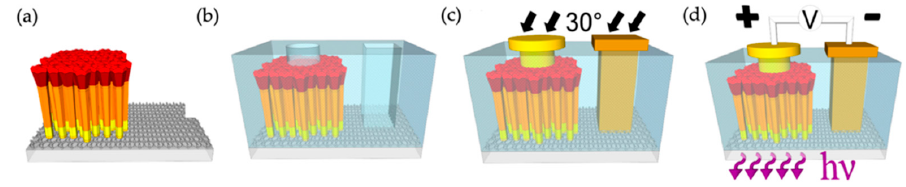
Figure 6. ( a ) Schematic of AlGaN nanowire UV LED structures grown on the graphene ‐ coated glass substrate. ( b ) Openings in polymer for metal contacts to AlGaN nanowires and graphene. ( c )